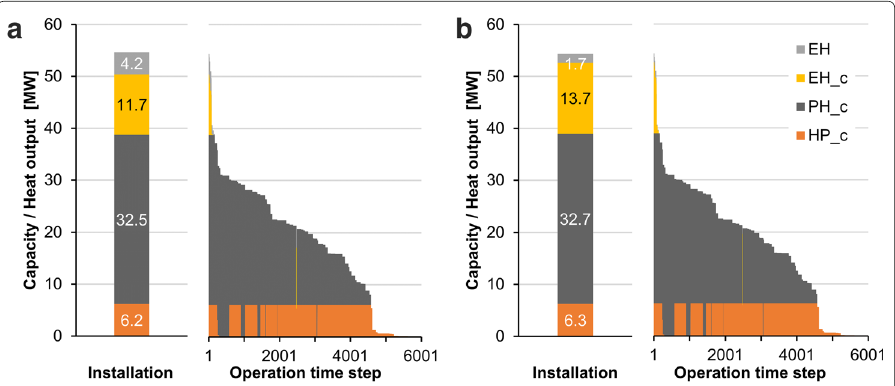
Fig. 4 Installed capacities and operation duration curves of heating units within the entire system. Central heat pumps (HP_c) and central pellet heaters (PH_c) provide base load, central and decentral electric heaters (EH_c and EH, respectively) provide peak